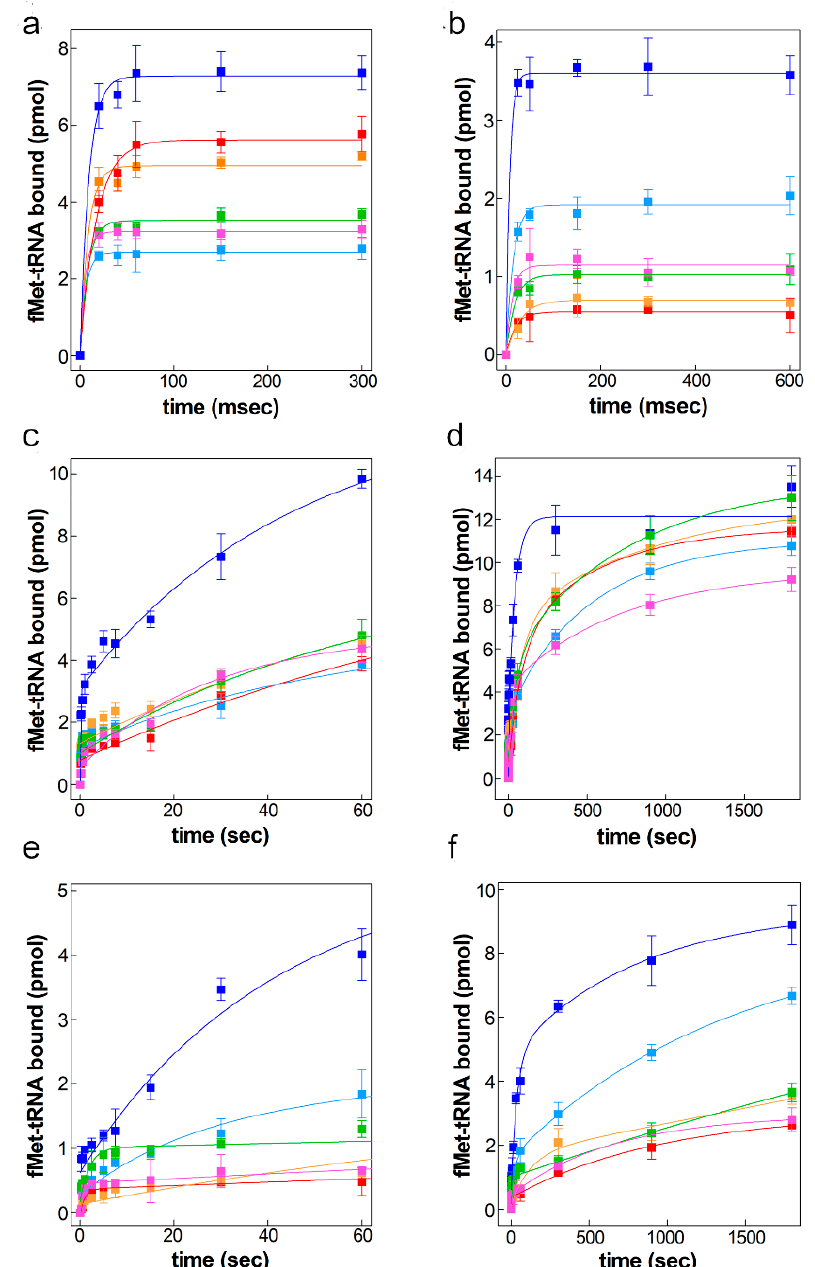
Figure 4. Kinetics of 30S initiation complex formation with various mRNAs. Kinetics of fMet-tRNA binding at ( a ) 37 ◦ C and ( b ) 15 ◦ C to ( a , b ) 30S subunits pre-incubated with different mRNAs and kinetics ( c , d , e , f ) upon offering simultaneously fMet-tRNA and the various mRNAs to the 30S subunits at ( c , d ) 37 ◦ C and ( e , f ) 15 ◦ C. Binding was followed by fast filtration on nitrocellulose using a quenched-flow apparatus and therefore measures the formation of a “locked” 30S IC. The 30S subunits contained a (1:1) stoichiometric equivalent of IF1, IF2–GTP and IF3 and the mRNAs used were: cspA (dark blue); cspD (red); A 1 A 2 D 3 (light blue); A 1 D 2 D 3 (green); D 1 A 2 A 3 (magenta); D 1 D 2 A 3 (orange). Each data point is the mean of quadruplicates; error bars represent the standard deviation. The radioactivity incorporated in the absence of mRNA was taken as background and was subtracted from each point. Further details are given in Materials and Methods.